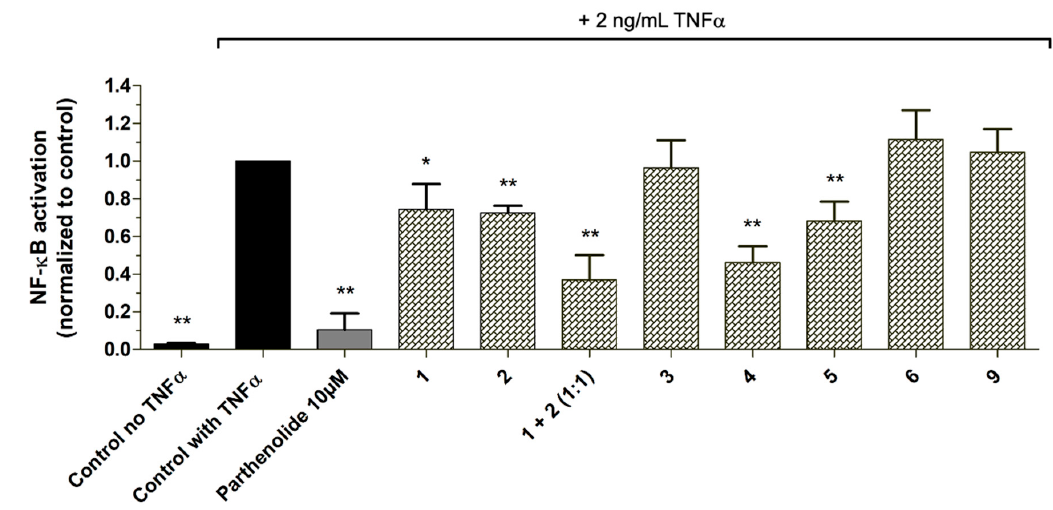
Figure 9. Residual NF-kB activity (normalized to the vehicle control with TNF α ) in TNF α (2 ng / mL)- activated HEK293–NF-kB-luc cells after treatment with the compounds 1 – 6 , 9 and a 1:1 mixture of 1 and 2 (all tested at 10 μ g/mL) and the positive control parthenolide (10 μ M). The luciferase signal derived from the NF-kB reporter was normalized to CTG-fluorescence and expressed as fold change normalized to the vehicle control (0.1% DMSO) with TNF α . Bar charts represent (residual) NF-kB transactivation activity expressed as mean ± SD. n = 4; ∗ p < 0.05 and ∗∗ p < 0.01 as compared to the control with TNF α .